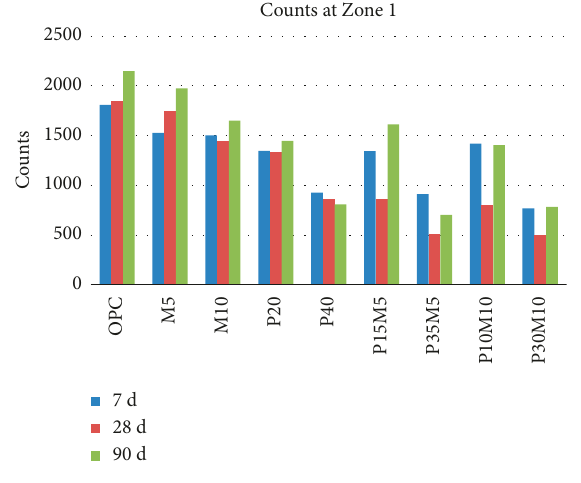
Figure 11: XRD analysis at zone 1 (Figure 5).